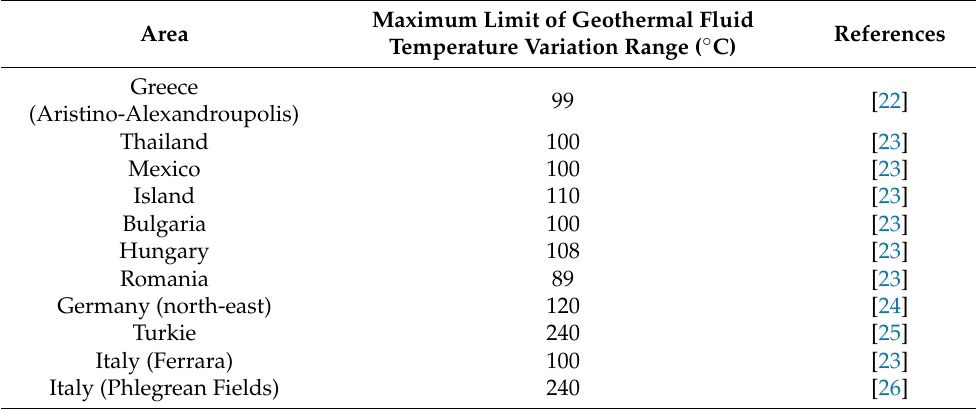
Table 1. Maximum limit of geothermal fluid temperature variation range in areas with geothermal